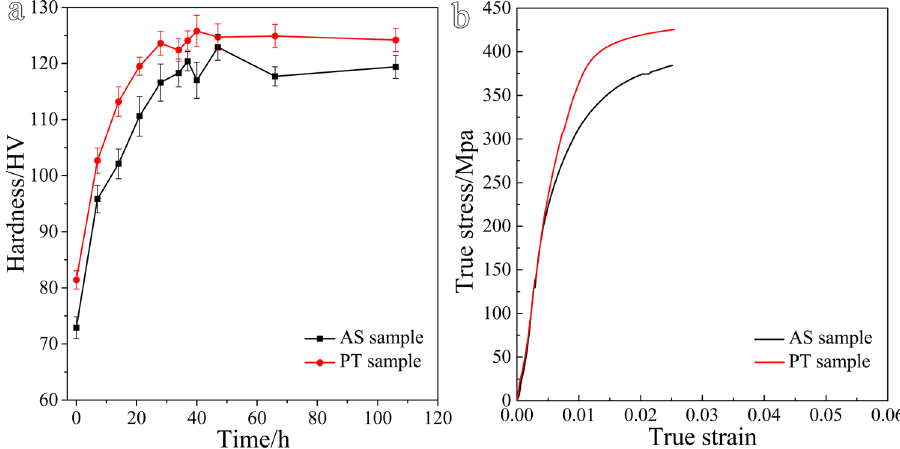
Figure 1. ( a ) Vickers hardness as function of time of Mg-15 Gd–0.5 Zr rods aged at 180 °C and ( b ) true stress- strain curves of peak aged sample under tension along the ED at room temperature.